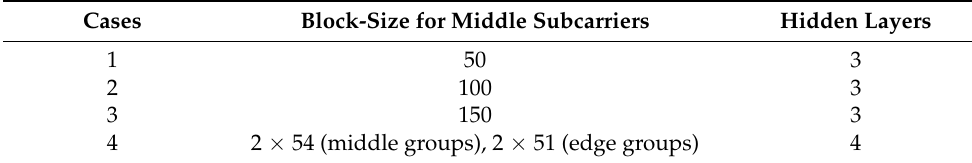
Table 3. Different cases of block-size for middle subcarriers and number of hidden